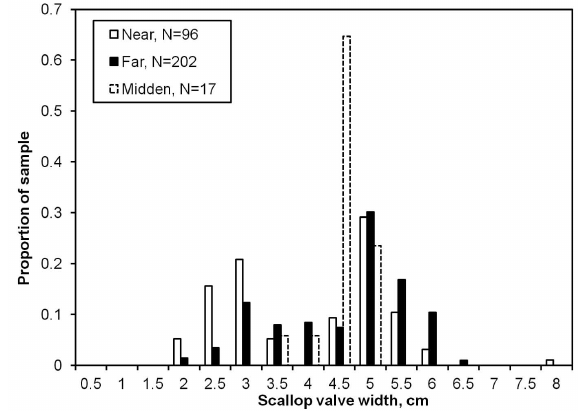
Fig. 3. – The size distribution by scallop valve width of Mima- chlamys asperrimus (doughboy scallop) in an extended midden of Octopus tetricus , and at 3 m (near) and >20 m (far) from the midden